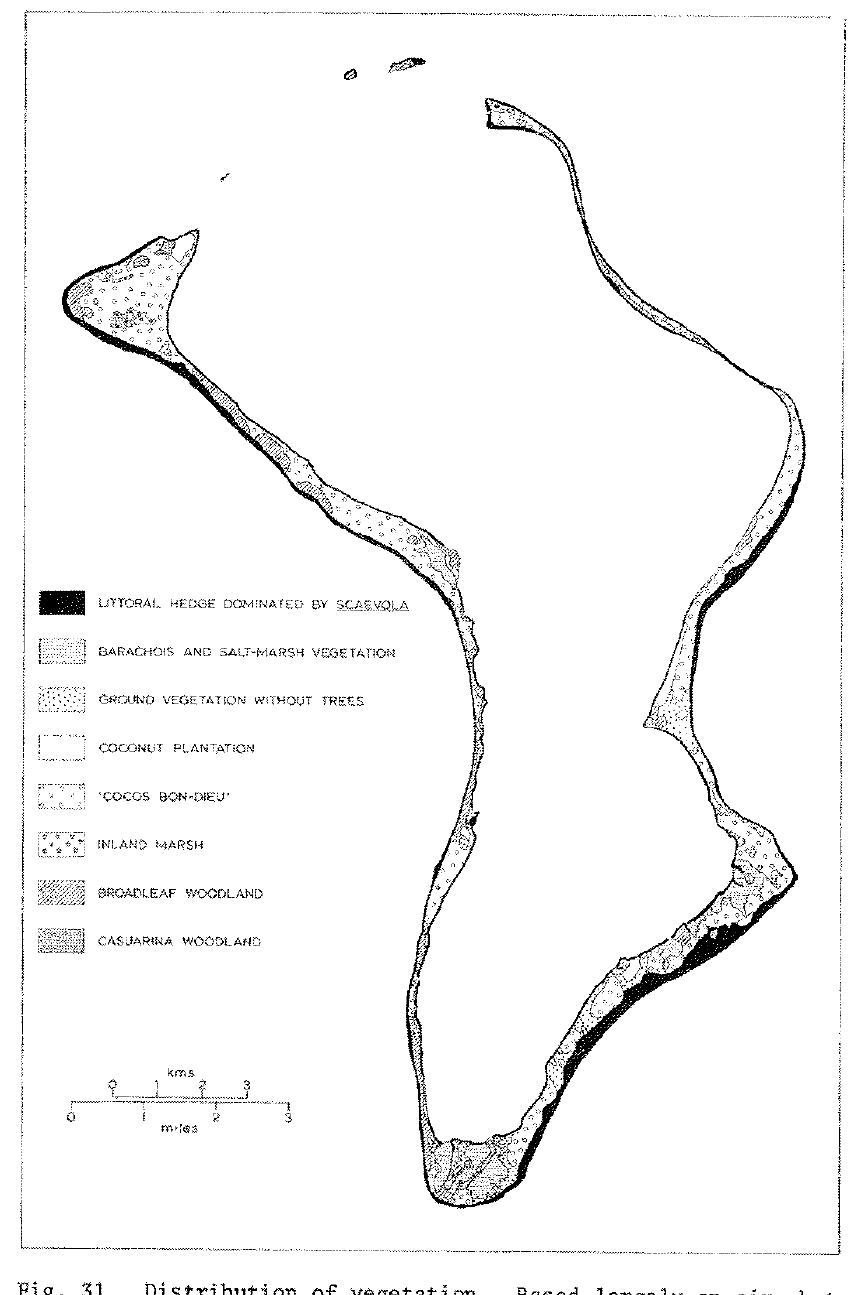
Figure 1. The map of Diego Garcia from Stoddart (1971) which was used to digitize the shoreline by Hamylton and East. Reprinted from Figure 31 of